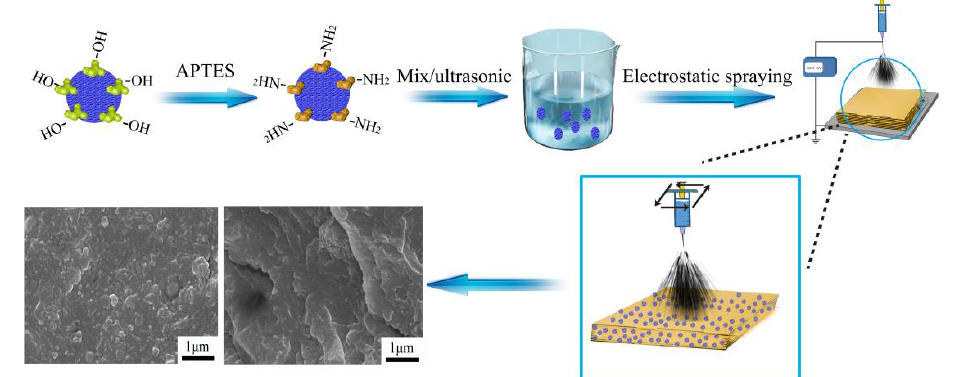
Figure 1. The schematic workflow of the preparation of the PEM.